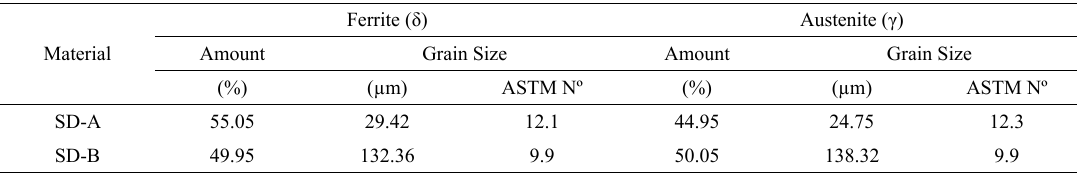
Table 2. Phases Proportions and grain sizes of SDSS